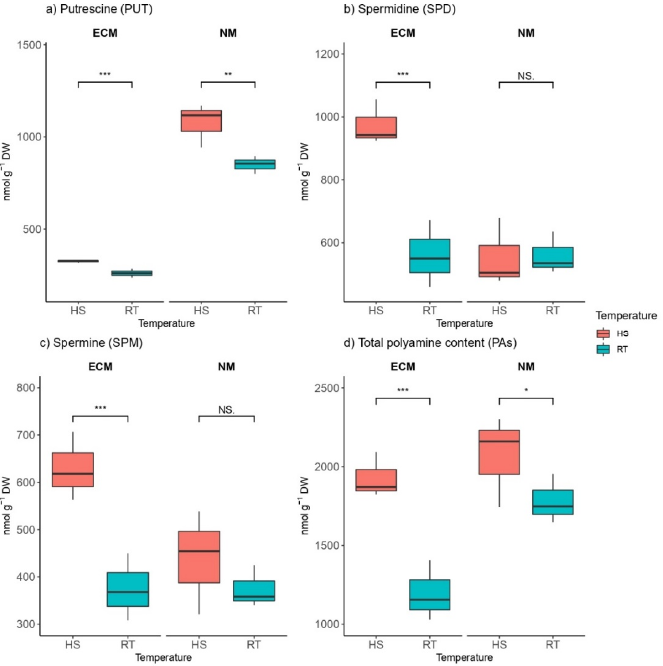
Figure 4. Changes in ( a ) Putrescine (PUT, nmol g − 1 DW), ( b ) Spermidine (SPD, nmol g − 1 DW), ( c ) Spermine (SPM, nmol g − 1 DW), and ( d ) total polyamine content (Pas, nmol g − 1 DW) in leaves of Q. robur . Treatments: HS—heat-stress-treated oak seedlings, RT—control oak seedlings grown at room temperature, ECM—oak seedlings inoculated with ectomycorrhiza inoculum, and NM—oak seedlings not inoculated with ectomycorrhiza inoculum. Significance levels: NS—non-significant and significant ((*) <0.05, (**) <0.01, and (***)